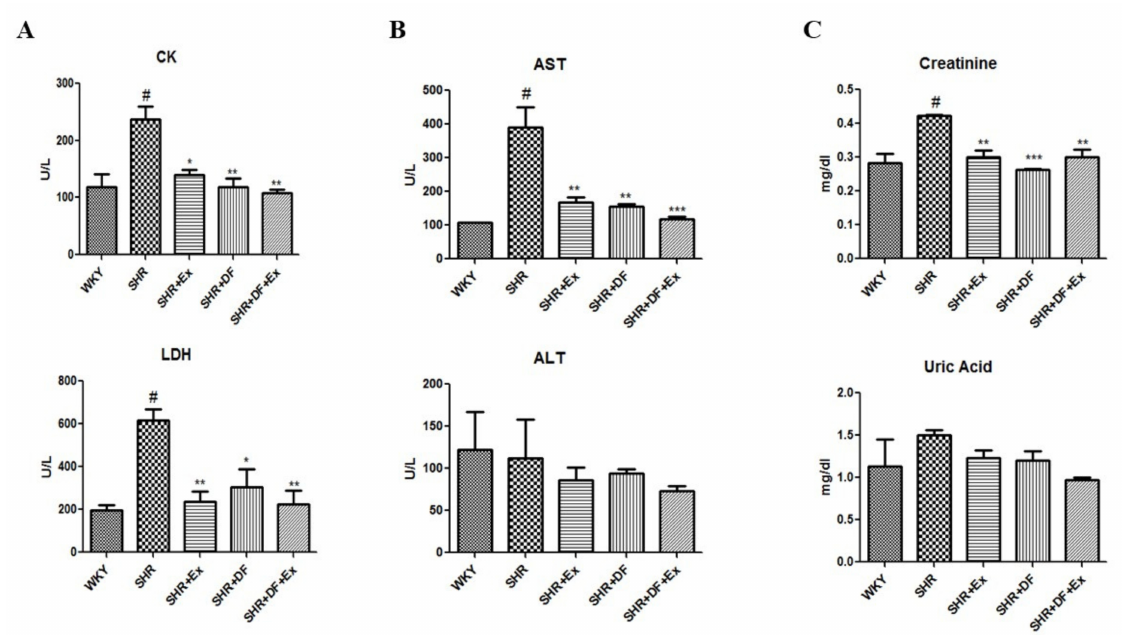
Figure 3. Effect of DF and exercise on myocardial injury markers and cardiac, hepatic, and renal function markers of WKY and SHR rats. ( A ) Creatine kinase and lactate dehydrogenase. ( B ) Aspartate transami- nase and alanine transaminase. ( C ). Creatinine and uric acid. Each bar represents mean ± SD ( n = 8).